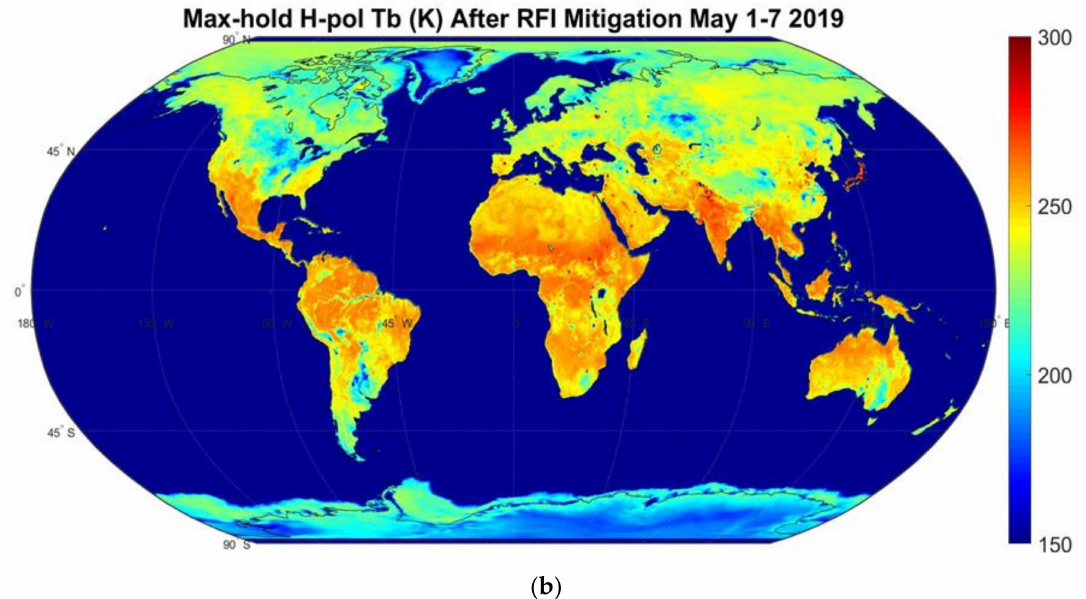
Figure 1. Soil Moisture Active–Passive ( SMAP ) Max-hold horizontally polarized (H-pol) brightness temperatures between 1 and 7 May 2019 ( a ) before and ( b ) after radio frequency interference ( RFI ) mitigation on 0.25 ◦ × 0.25 ◦ gridded maps.